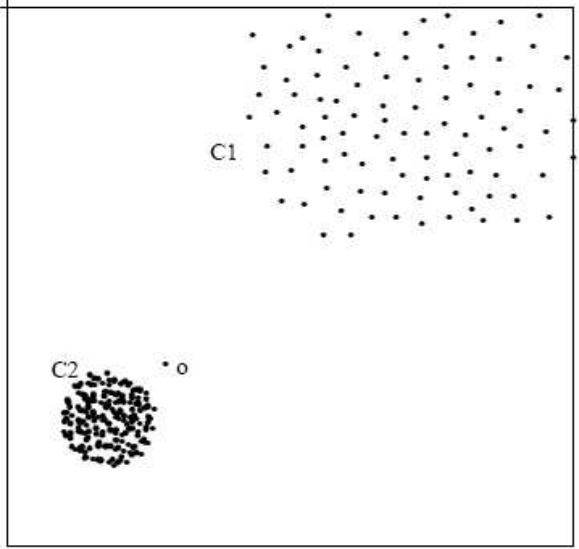
Figure 3. A sample dataset showing the advantage of LOF over DB ( k, λ )